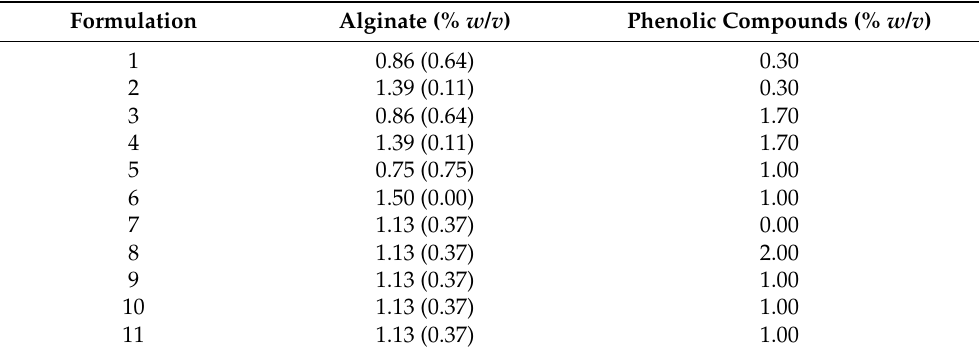
Table 7. Composition of the different film formulations produced with alginate (alginate + glycerol content fixed at 1.5 % ( w / v ) and glycerol values are presented in parentheses) and amaranth phenolic compounds using a 2 2 central composite rotatable design (CCRD). Formulation Alginate (% w / v ) Phenolic Compounds (% w / v